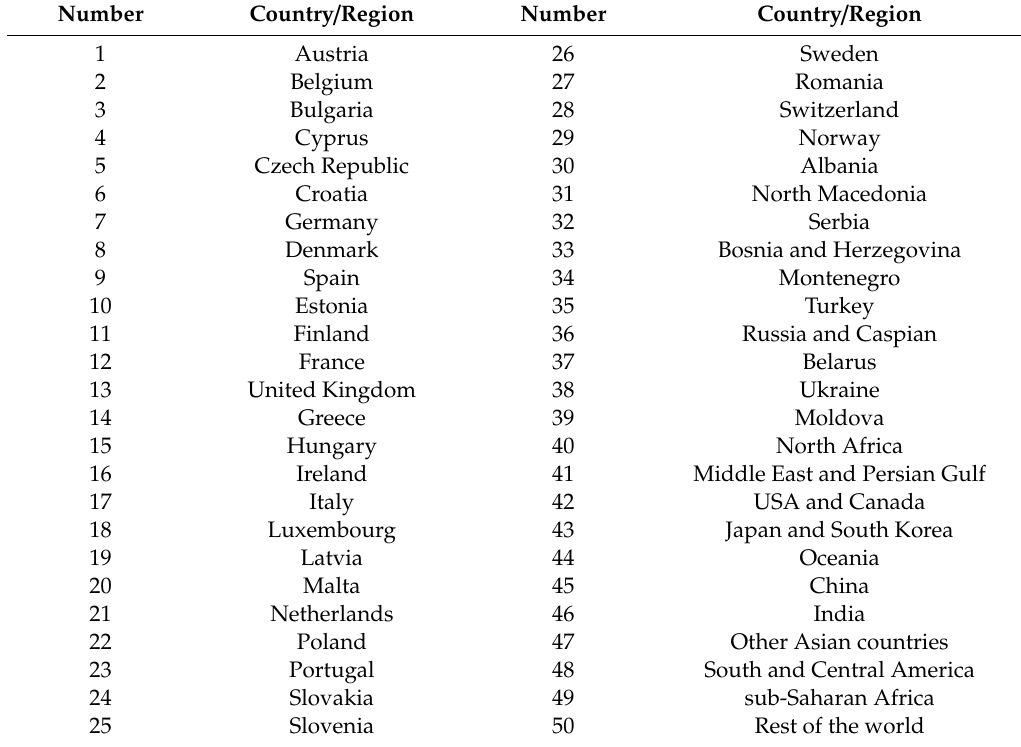
Table 1. Geographical coverage of the GEM-E3-R country layer